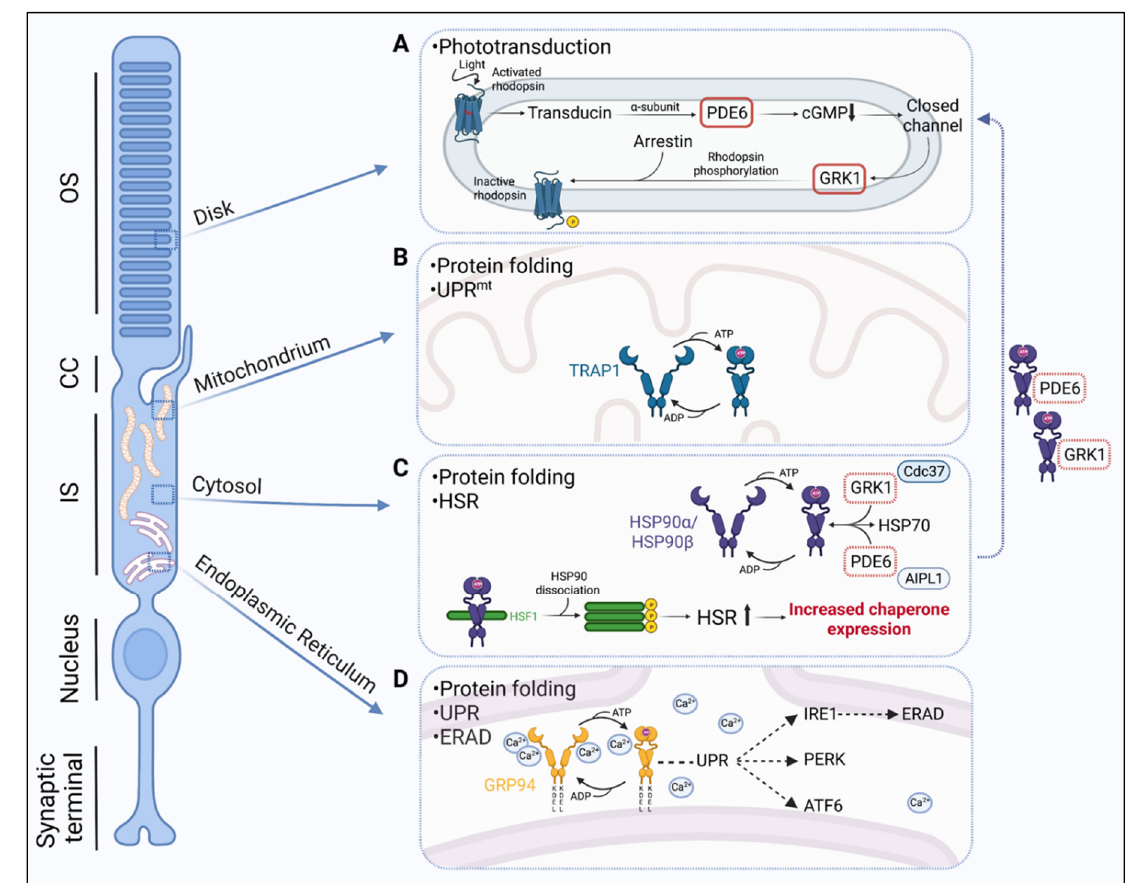
Figure 1. The roles of Hsp90 in photoreceptor proteostasis. ( A ) PDE6 and GRK1 are important components of phototransduction activation and deactivation, respectively. PDE6 and GRK1 are synthesised in the photoreceptor inner segment and translocated to the outer segment via the connecting cilium. Both PDE6 and GRK1 are Hsp90 client proteins. ( B ) The mitochondrial